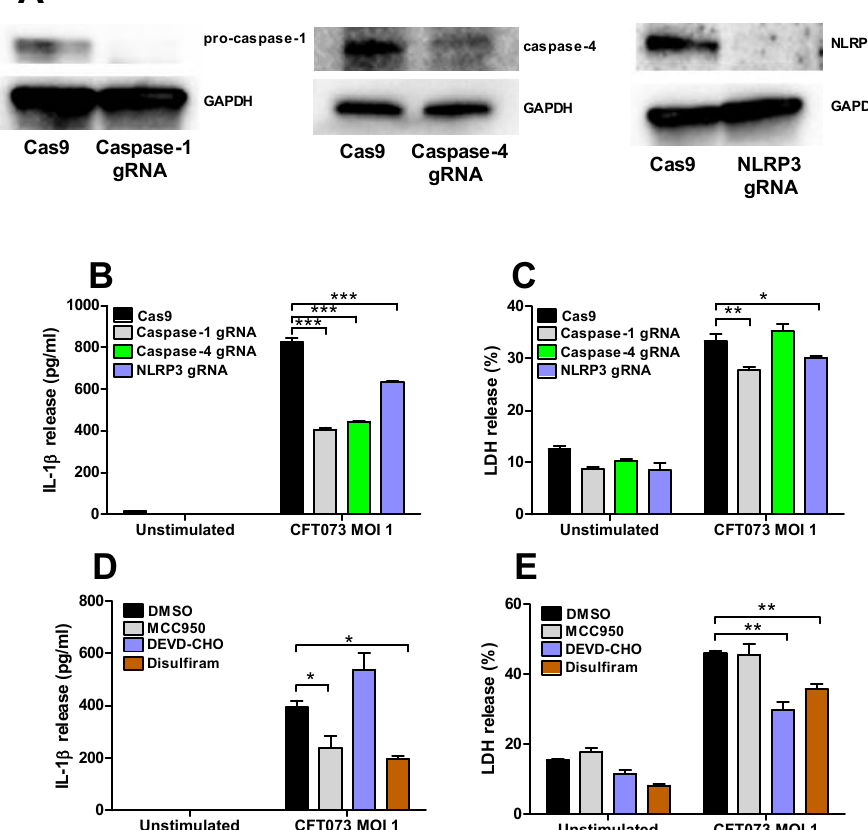
Figure 6. Inflammasome-associated proteins role in IL-1 β and LDH release. The knockdown of caspase-1, caspase-4 and NLRP3 in renal fibroblasts cells using the CRISPR/Cas9 system was evaluated by Western blot analysis. GAPDH was used as the loading control ( A ). IL-1 β ( B ) and LDH ( C ) release from Cas9, caspase-1, caspase-4 or NLRP3-deficient renal fibroblasts after infection with UPEC strain CFT073 at MOI 1 for 6 h. Renal fibroblasts were pre-incubated with DMSO (vehicle), caspase-3 inhibitor Ac-DEVD-CHO (10 µM), NLRP3 inhibitor MCC950 (2 µM) or the Gasdermin D inhibitor Disulfiram (10 µM) for 1 h prior to infection with CFT073 at MOI 1 for 6 h followed by analysis of IL-1β ( D ) and LDH ( E ) release. Data are presented as mean ± SEM of 3 independent experiments (* p < 0.05, ** p < 0.01, *** p < 0.001).